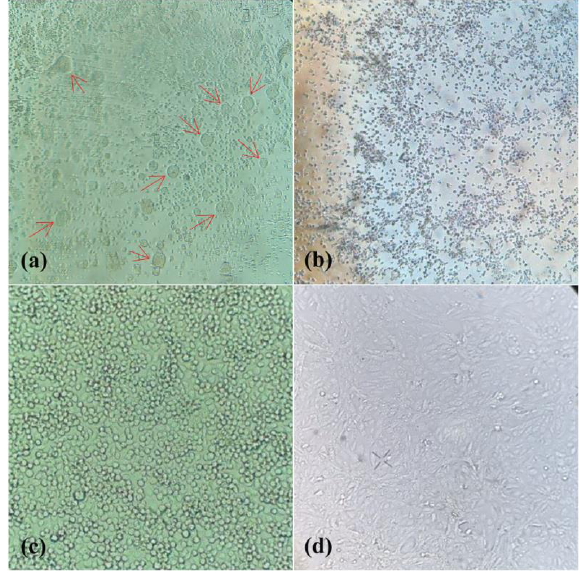
Figure 3. Cytopathic effect (ECP) displayed by C6/36 and Vero cell lines inoculated with sample BeAr848894. ( a ) ECP in C6/36 cells showing formation of syncytium highlighted by red arrows. ( b ) ECP in Vero cells, with modification in the cell morphology and destruction of the monolayer. ( c ) negative control C6/36 cells, showing intact monolayer and normal cell morphology. ( d ) Negative control Vero cells, showing intact monolayer and normal cell morphology.